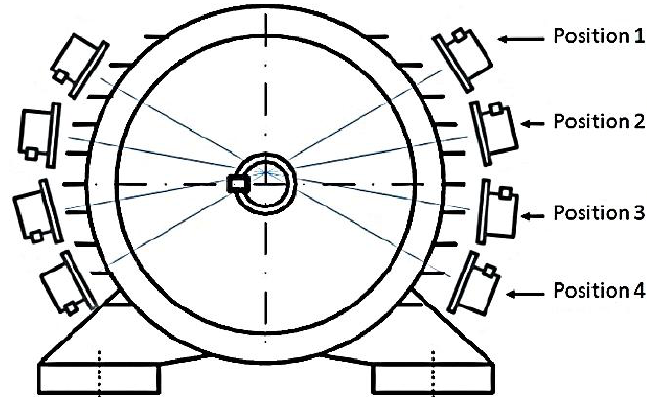
Figure 22. Four pairs of sensors [94].